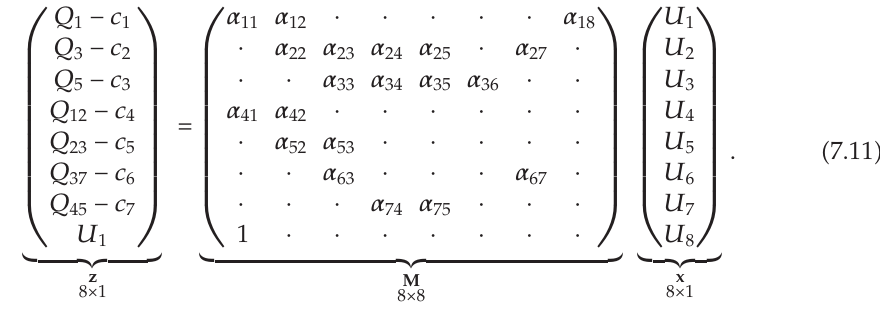
Figure 9 (cid:8) c (cid:9) shows the associated network derived from (cid:8) 7.11 (cid:9) , where branch admittances were suppressed in order to clarify the drawing. The numbers close to the oriented edges of the graph denote the order of the measurement from which the edge is derived, that is, the order of the elementary network in which it is defined. Note that the only branch